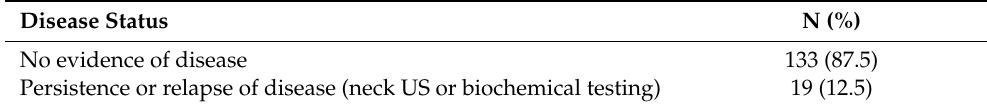
Table 2. Disease status of study participants at last